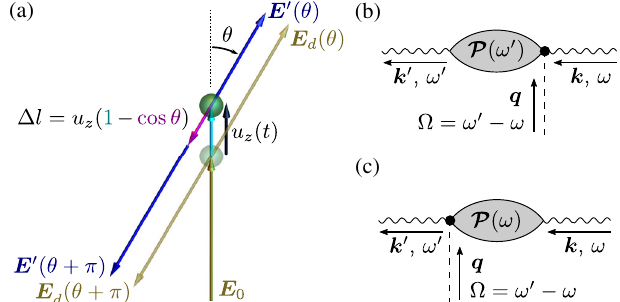
FIG. 2. (a) A sketch of light scattering on a trembling particle. The incident and elastically scattered light are shown by yellow color, inelastically scattered light is shown by blue color. Inelastic scattering is caused by the temporal modulation of the optical path (cyan and magenta arrows) due to particle displacement. (b), (c) Diagrammatic representation for the inelastic light scattering on a trembling particle. Wavy lines denote photons, bubbles correspond to the dressed polarization operator of the particle at rest, dashed lines represent mechanical displacement, solid dot stands for the optomechanical interaction given by Eq. (A5).